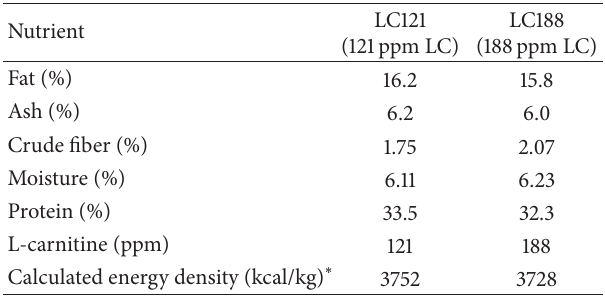
Table 1: Guaranteed analysis on an “as fed” basis of final products fed to cats. All analyses represent an average of triplicate